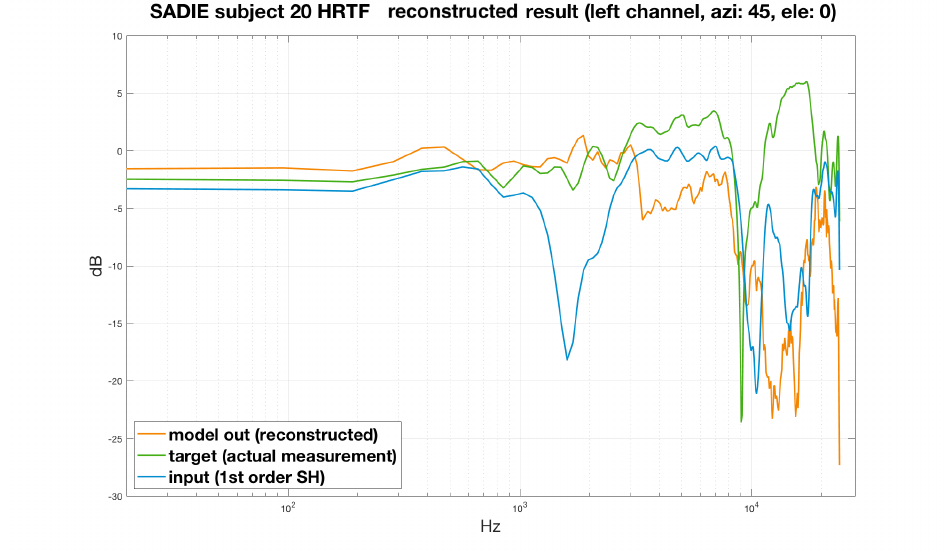
Figure 5. Restoration result example for ipsilateral HRTF response with CAE only (orange: model restored output, green: actual HRTF measurement, blue: SH-interpolated